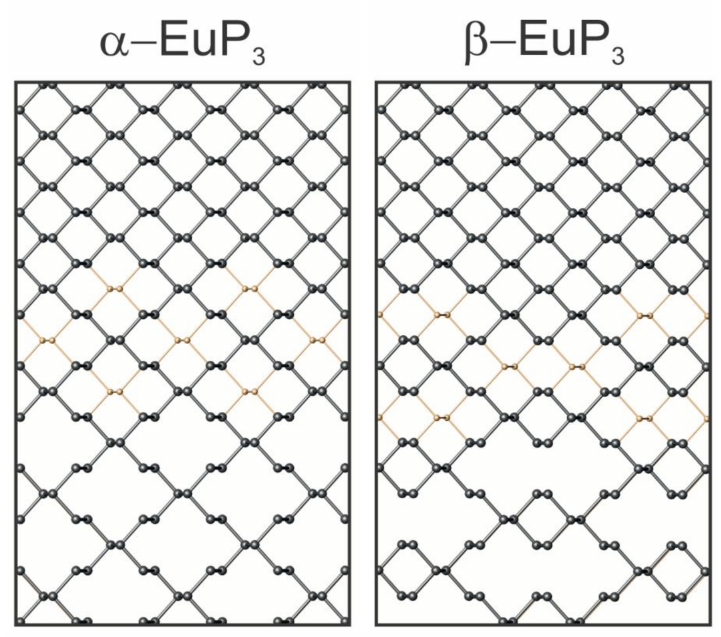
Figure 4. The evolution of phosphorus frameworks from black phosphorus (top) to the two phases of EuP 3 (bottom) are shown. The gold atoms depicted (middle) indicate the P atoms that are absent in the EuP 3 frameworks.